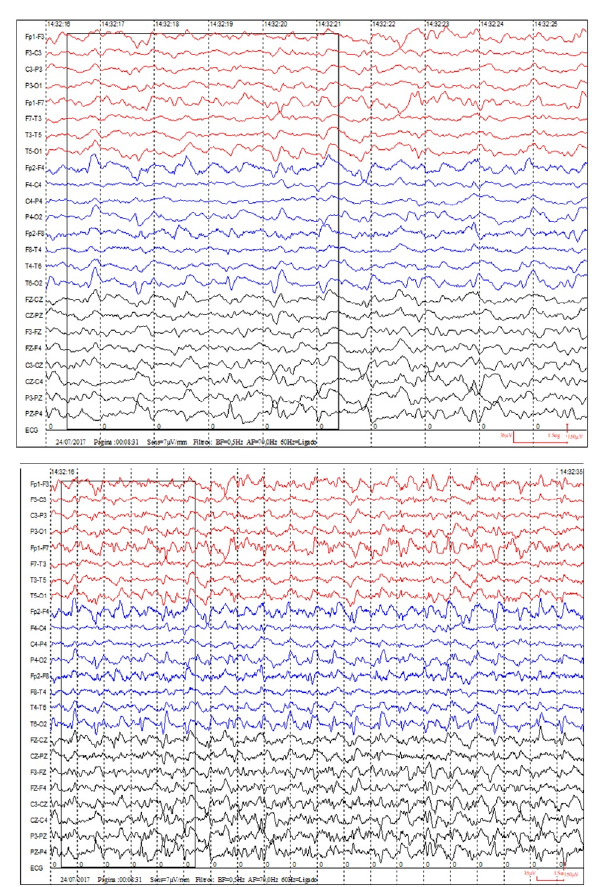
Figure 2. Electroencephalogram with periodic activity, biphasic or triphasic morphology, of 0.8–1.3 seconds, with diffuse distribution, lateralized to the right cerebral hemisphere, and predominantly posterior.